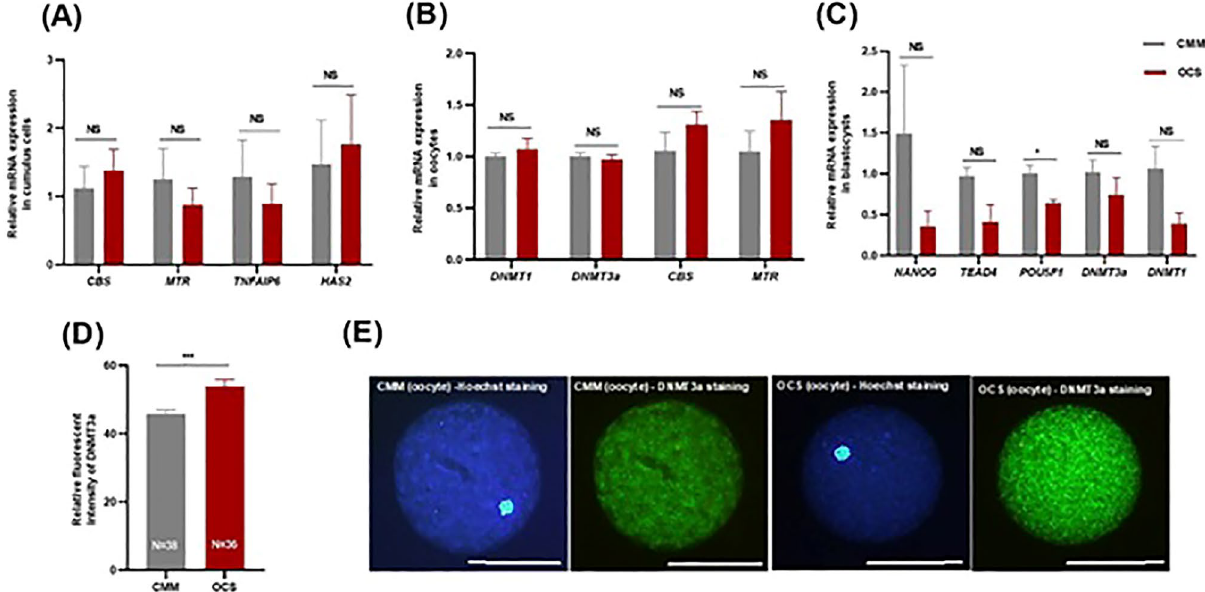
Figure 7. Effect of one carbon supplementation on relative mRNA expression of target genes in ( A ) cumulus cells, ( B ) matured oocytes and ( C ) blastocysts. ( D ) Effect of one carbon supplementation on DNMT3a protein expression in terms of fluorescent intensity in matured oocytes. ( E ) Representative images of DNMT3a immunocytochemistry in matured oocytes (20 × magnification; Scale bar, 100 µm). The data are shown as mean ± s.e.m. NS stands for non-significant differences ( P > 0.05). *Stands for P < 0.05. ***Stands for P ≤ 0.001. N stands for total number of oocytes in each